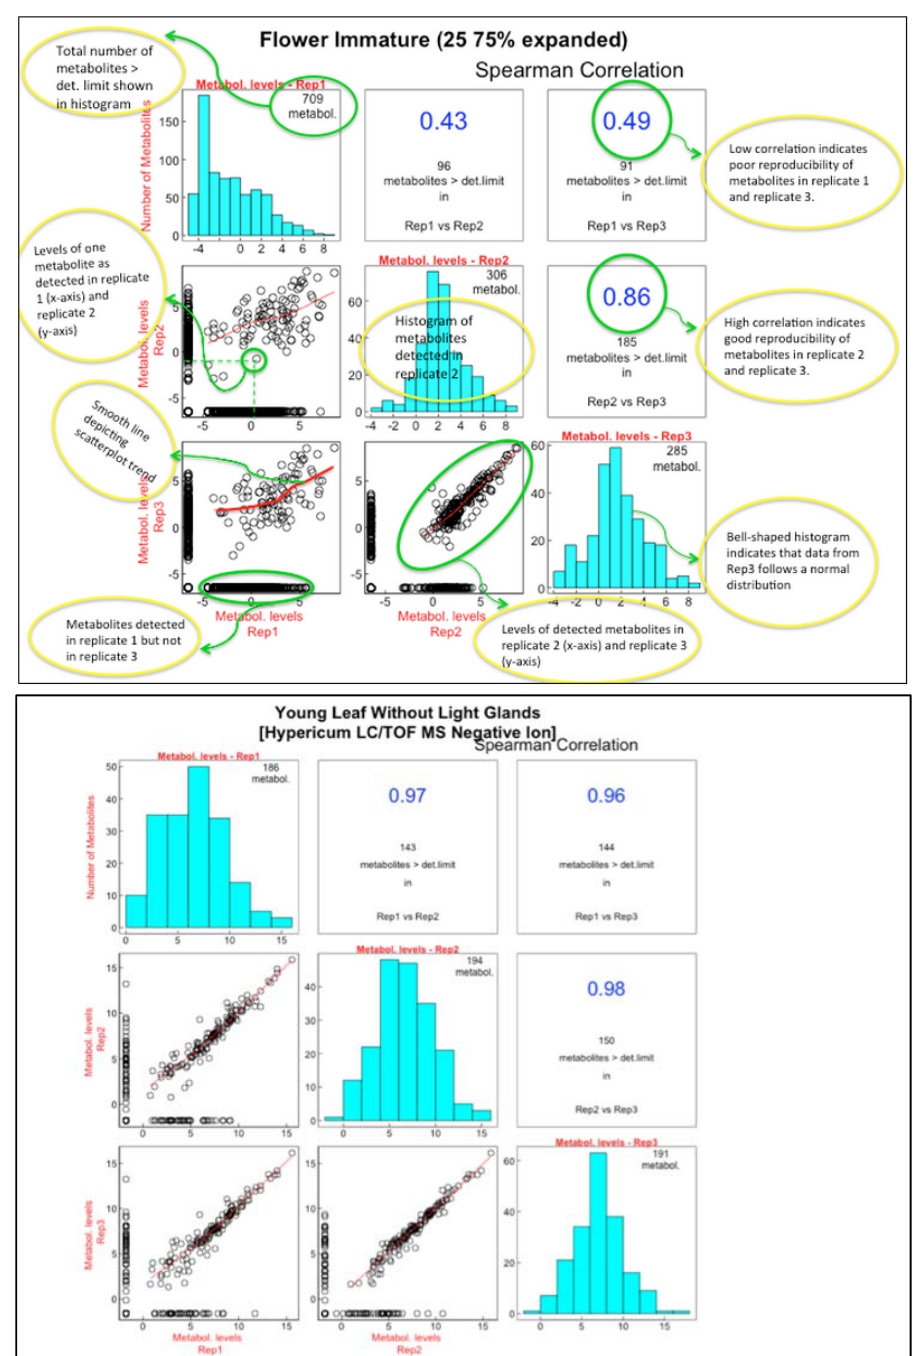
Figure 1. Scatterplots providing a rapid method for assessing the quality of metabolite